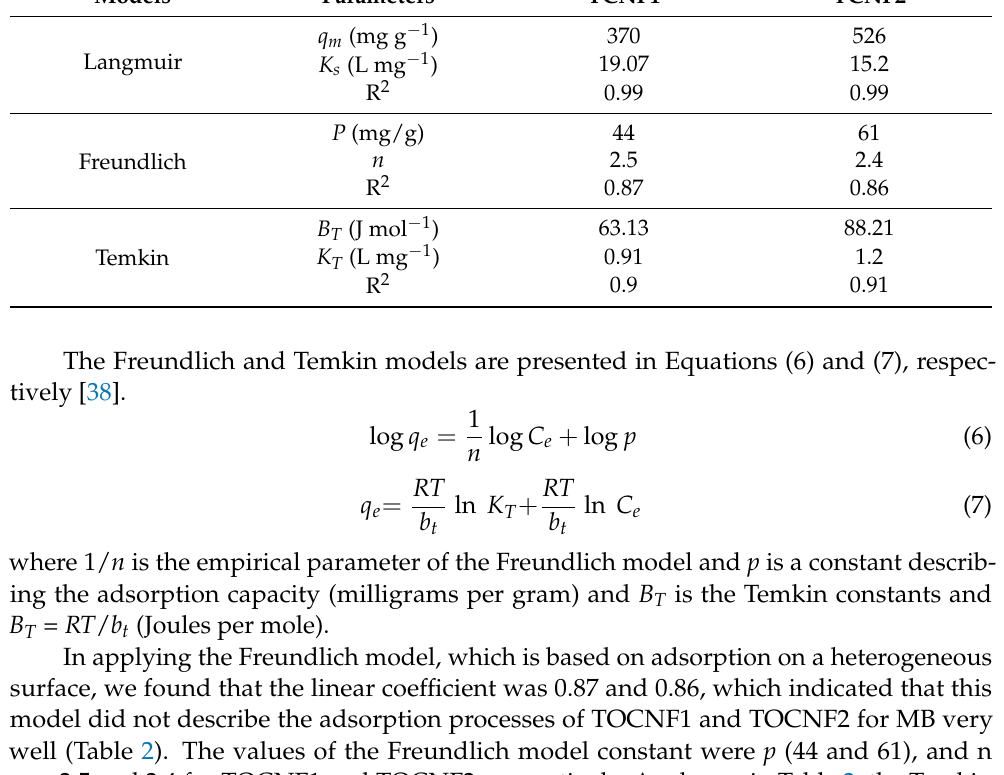
Table 2. Parameters for MB adsorption by TOCNF1 and TOCNF2 according to different equilibrium models.